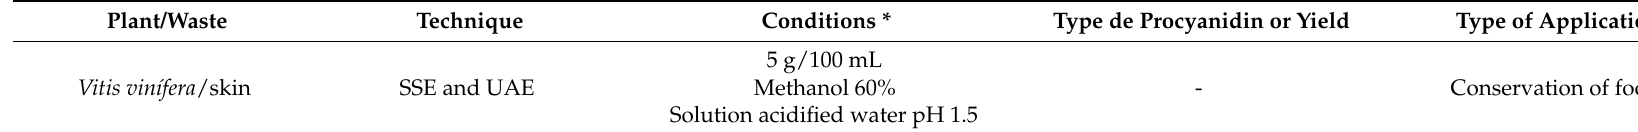
Table 3. Research on extraction of procyanidins from agro-industrial wastes, and future